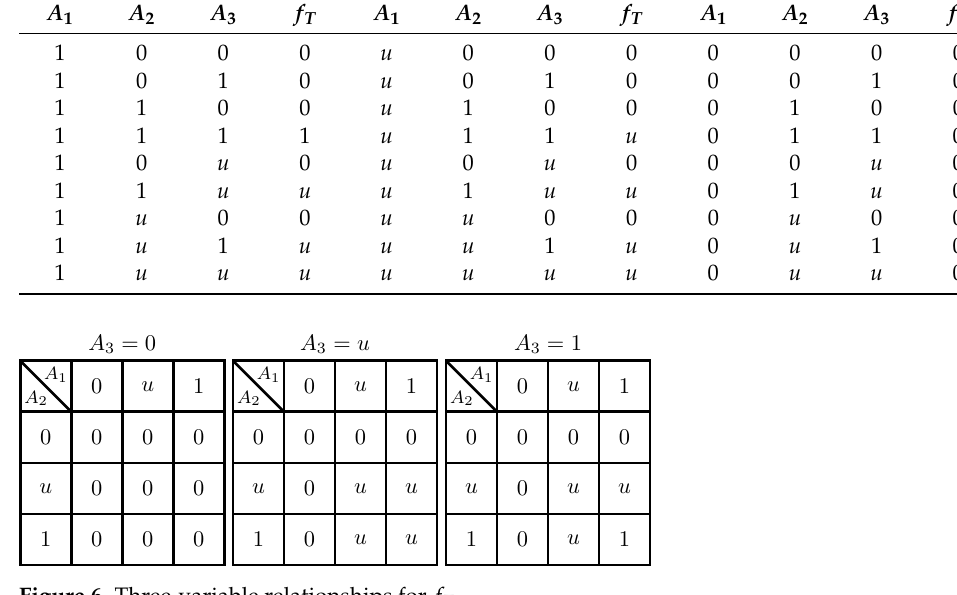
Figure 6. Three-variable relationships for f T